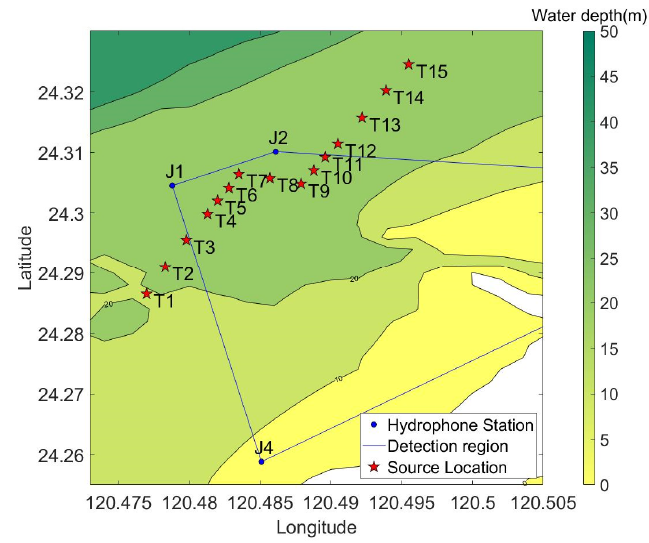
Figure 13. Detection region consisted of hydrophones.